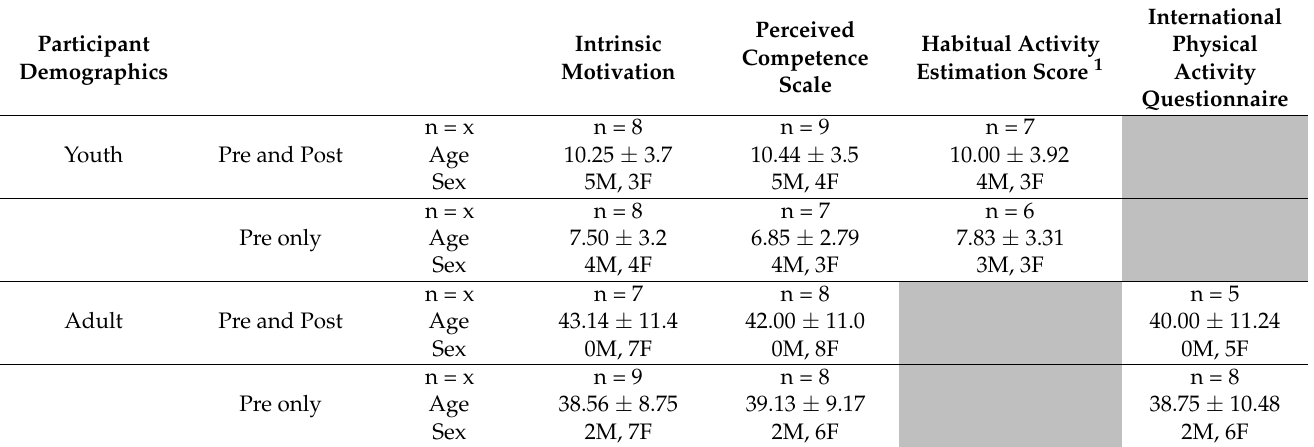
Table 1. Age and sex of fearless participants who completed the research